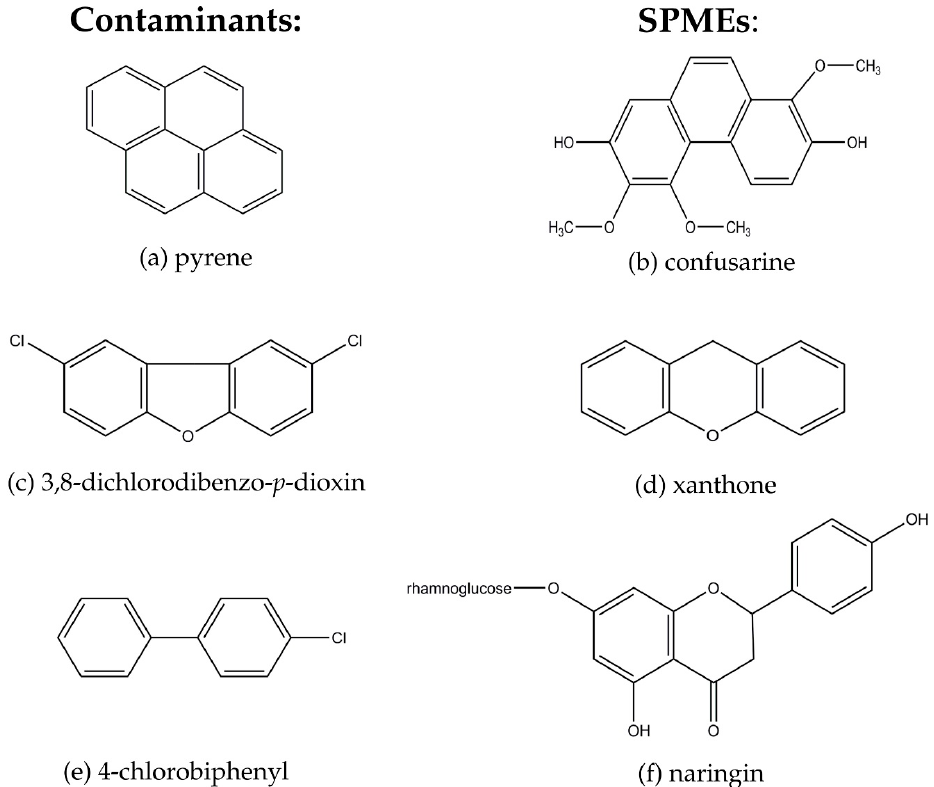
Figure 4. A few examples of structural similarities between contaminants and plant secondary metabolites (SPMEs), adapted from Singer et al. [18]. ( a ) pyrene; ( b ) confusarine; ( c ) 3,8-dichlorodibenzo- p -dioxin; ( d ) xanthone; ( e ) 4-chlorobiphenyl; ( f )